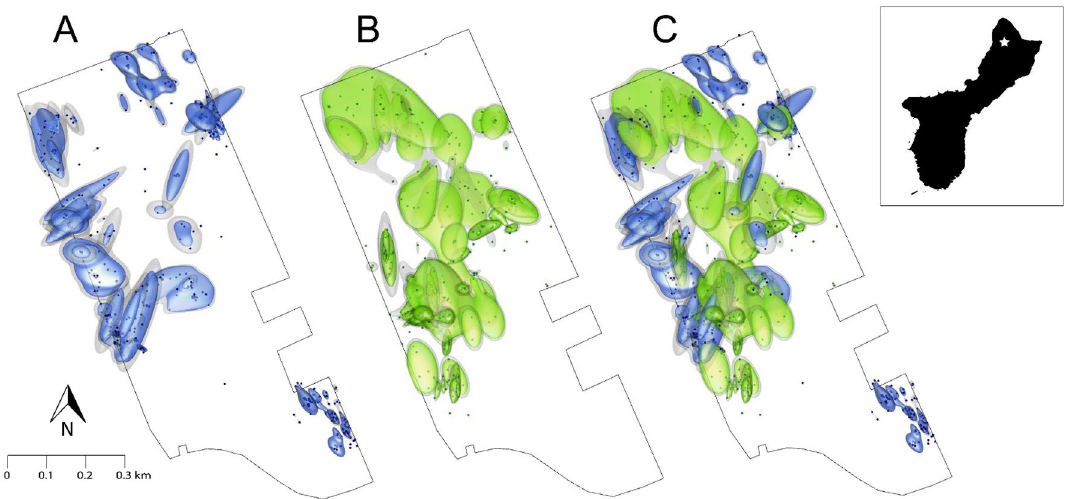
Figure 3. Three-dimensional activity volumes (3D Kernel Utilization Distributions, KUDs) of radiotracked brown treesnakes (BTS) frequenting the forest edge ( A blue 75% isopleths surrounded by grey 95% isopleths), the forest interior ( B green 75% isopleths surrounded by grey 95% isopleths), and combined ( C ) on Guam. Edge snakes (those with > 30% [mean = 63 ± 22%] of observations within 50 m of forest edge) had significantly smaller 3D activity volumes compared to interior snakes (those with < 30% [mean = 13 ± 7%] of observations within 50 m of forest edge; df = 18, T = − 2.29, p = 0.04). Outer black line in each panel represents the Habitat Management Unit (HMU, 13.596 N, 144.865 E) boundary fence. Inset shows the relative position of the HMU (indicated by the star) on the north end of